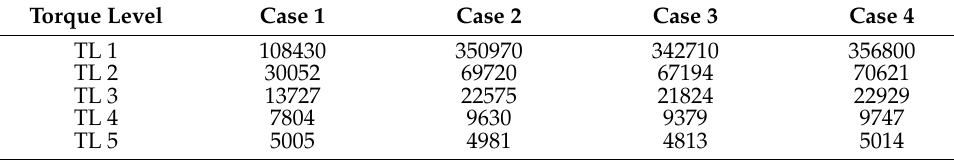
Table 7. The number of sit-to-stand movements with a fully charged battery (step). Torque Level